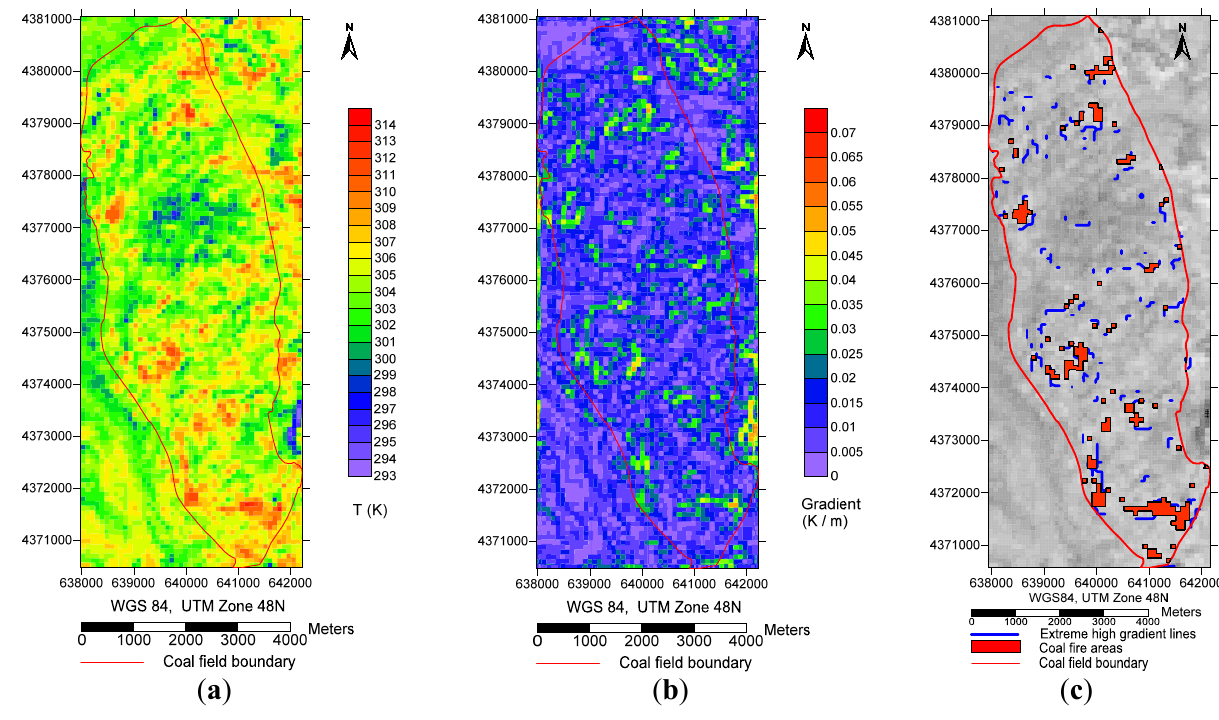
Figure 3. Gradient-based thresholding method, ( a ) daytime temperature image for 27 March 2013; ( b ) gradient image generated by an extended Sobel filter; ( c ) thinned extreme gradient lines (blue lines) and coal fire areas (red pixels) segmented by the final